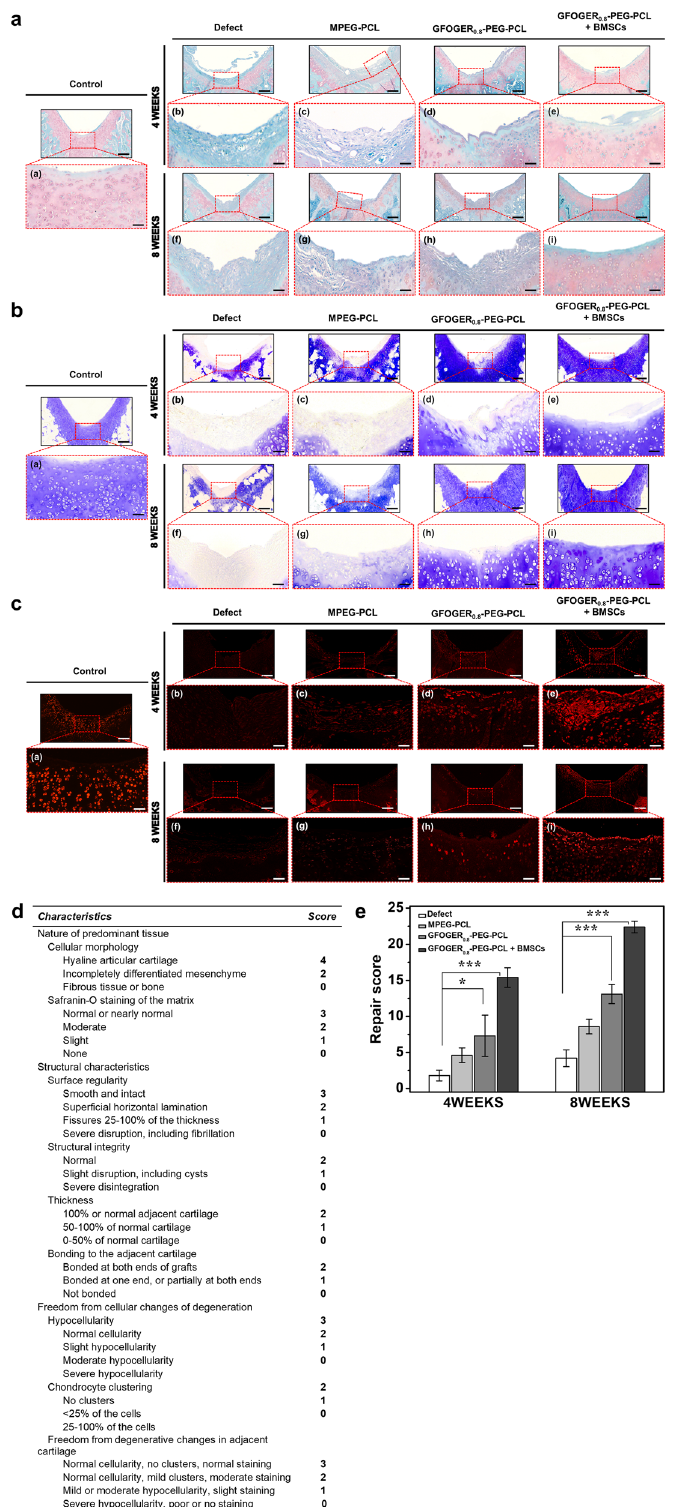
Fig. 8 Histological analysis of osteochondral repair in rats. a Safranin O/fast green, b toluidine blue staining of cartilage defect tissue after 4 and 8 weeks of repair. Scale bar: 200 and 100 μ m. c Immuno fl uorescence type II collagen staining of rat cartilage defect sites. Scale bar: 50 μ m. And the red frames indicate the magni fi ed cartilage area (a (a – i), b (a – i), and c (a – i)). d , e Macroscopic evaluation according to O ’ Driscoll histological scores (Data in ( e ) are shown as mean ± SD, unpaired Student ’ s t -test. * p < 0.05 and *** p <